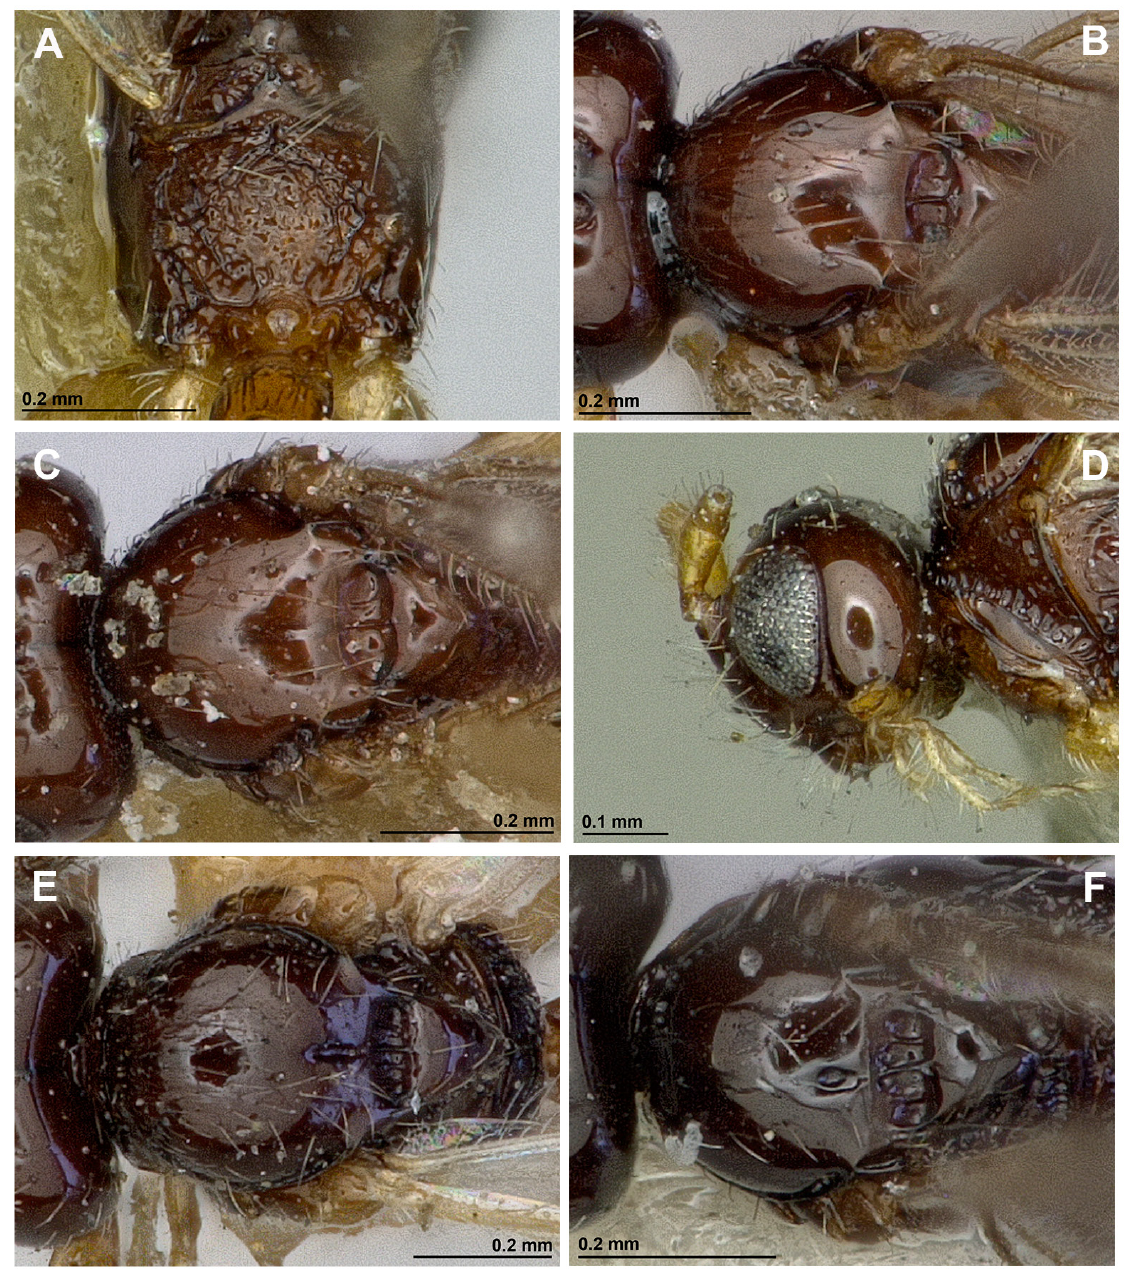
Fig. 13. A . Propodeum of Synaldis ulmicola Ashmead, 1889, dorsal view. B . Mesonotum of S.